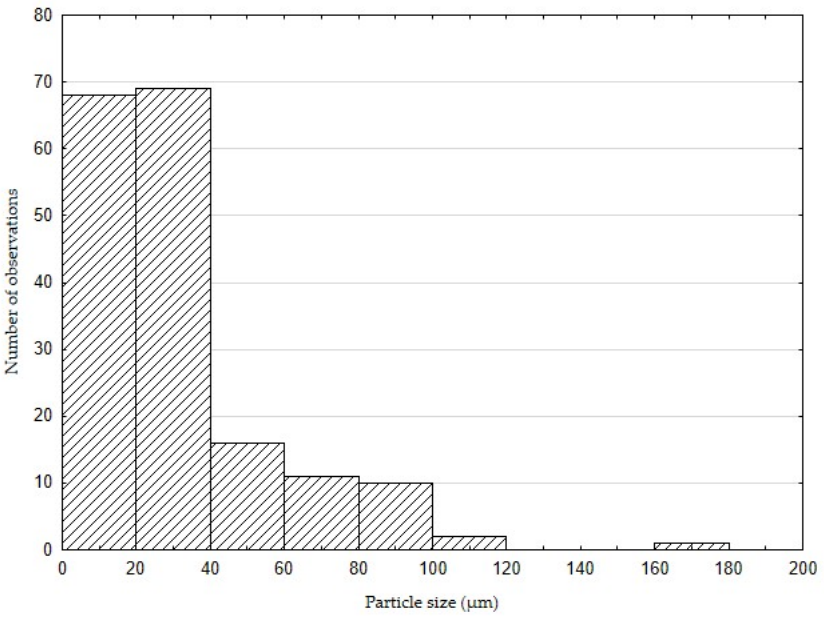
Figure 2. Histogram of coconut shell filler particle sizes.